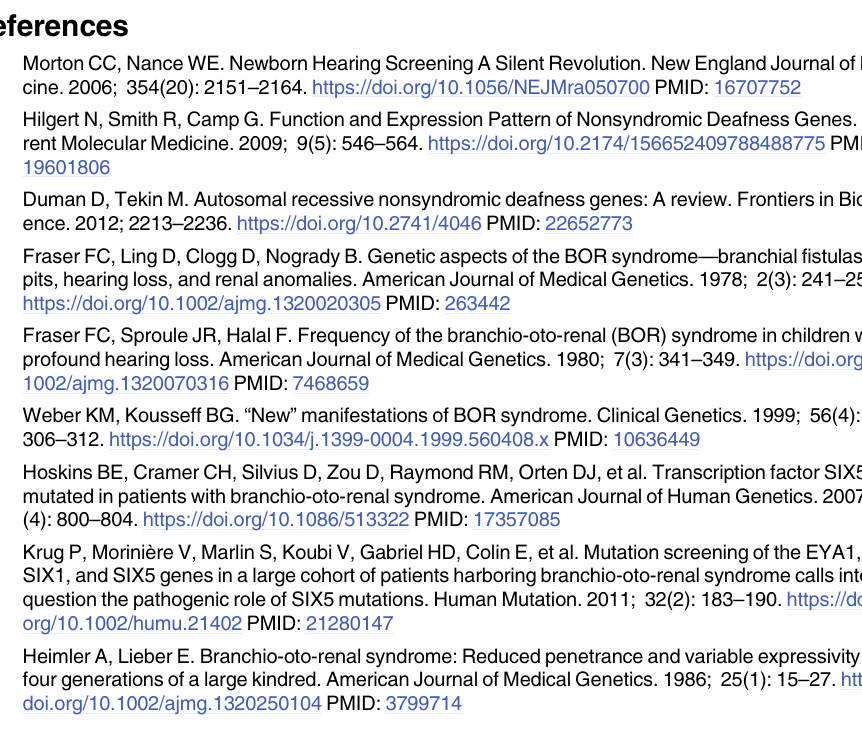
S1 Table. List of genes associated with hearing